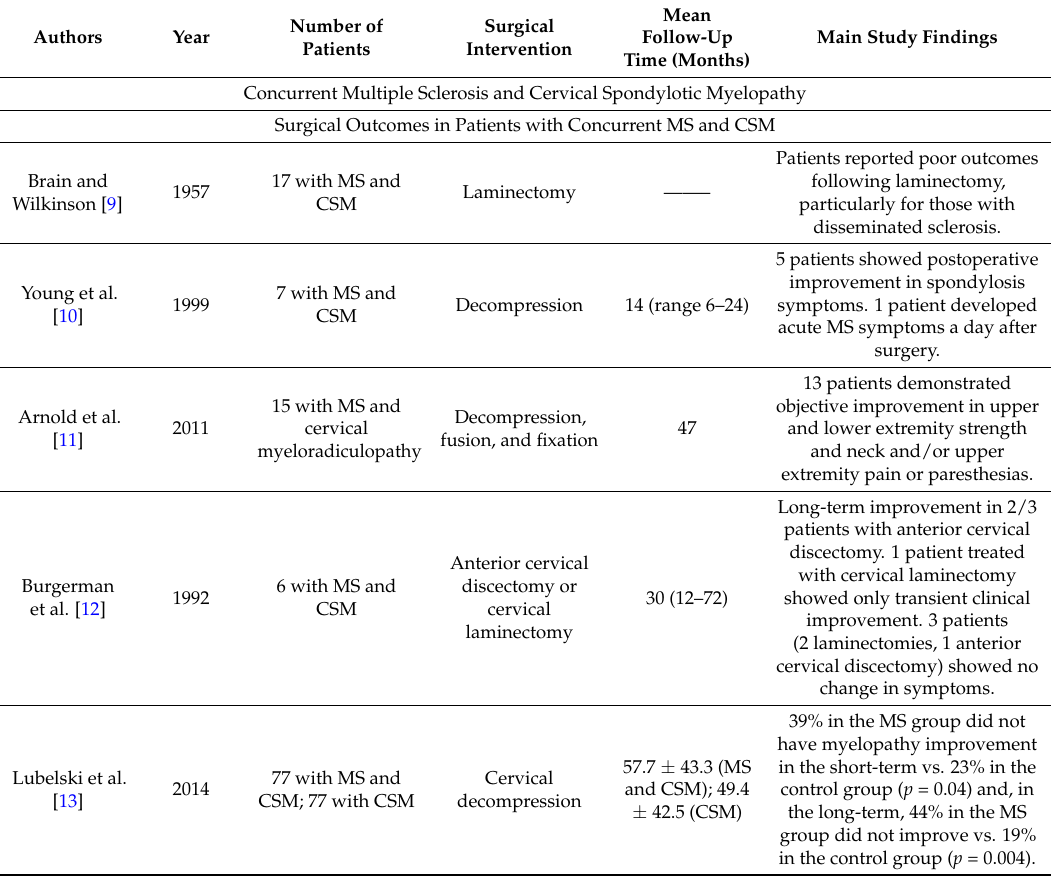
Table 1. Reviewed literature on demyelinating disease and coexisting disease with similar